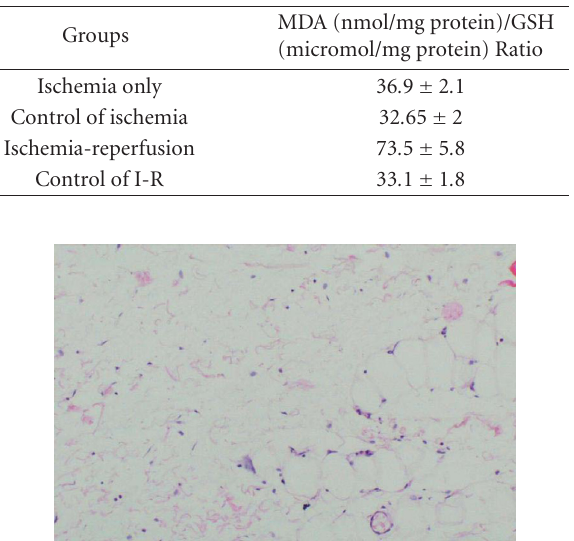
Statistical analysis